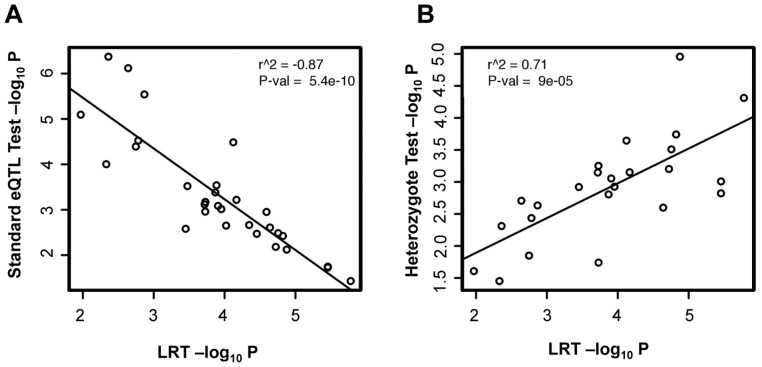
Comparison of separate association using maternal and paternal alleles with the Likelihood Ratio Test (LRT) for putative 30 ieQTLs.(A) Correlation between –log10 p-values generated using a standard association test and the LRT (r2 = −0.87) (B) Correlation between -log10 p-values generated using the heterozygote test and the LRT (r2 = 0.71). Note that 6 of the 30 SNP-gene pairs did not have a sufficient number of heterozygotes to perform the test.